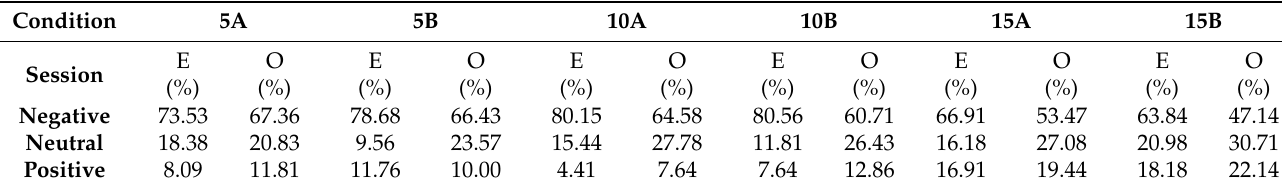
Table 2. Total Number of responses for surprise and dangerousness.